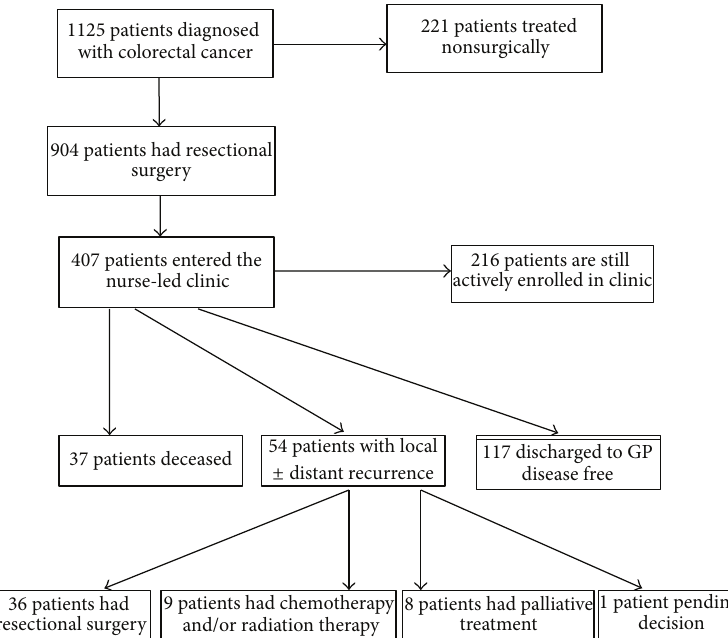
Figure 2: This demonstrates the flow of patients involved in the study. Table 1: Breakdown of the management of 54 patients who were diagnosed with recurrent disease in the nurse led follow-up clinic. Site of